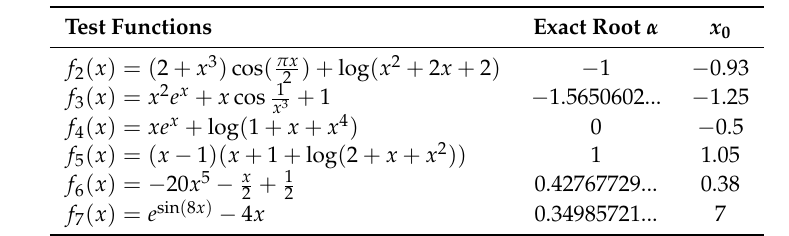
Table 2. Test functions.